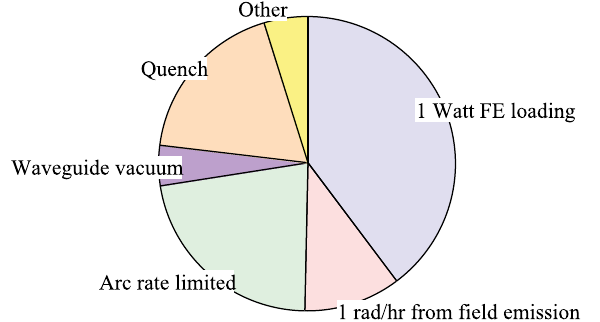
FIG. 8. Distribution of CEBAF cavity gradient limitations, 1995 (from [51]).